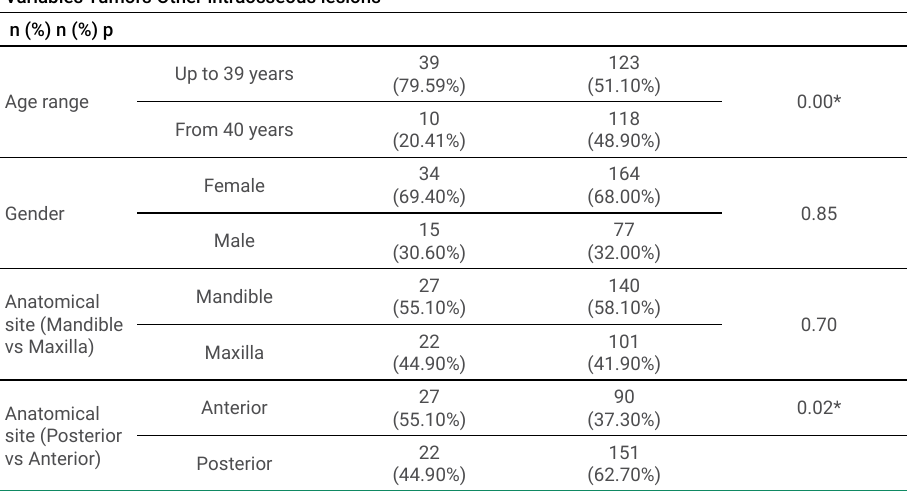
Table 1. Bivariate analysis of tumors of the maxillomandibular complex and other intraosseous lesions, CRLB, UEFS, 2006-2018. Variables Tumors Other intraosseous lesions n (%) n (%) p